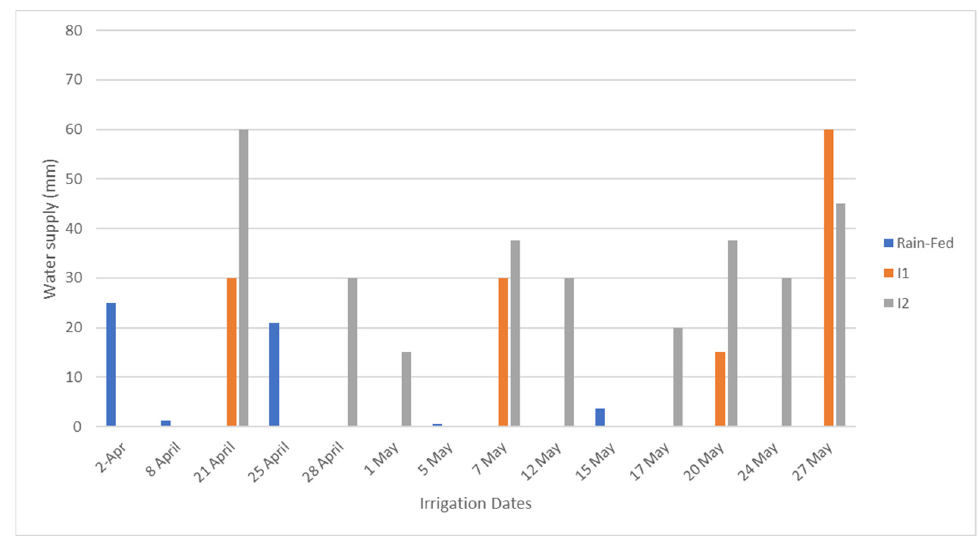
Figure 1. Water supply (mm) during the growing period.